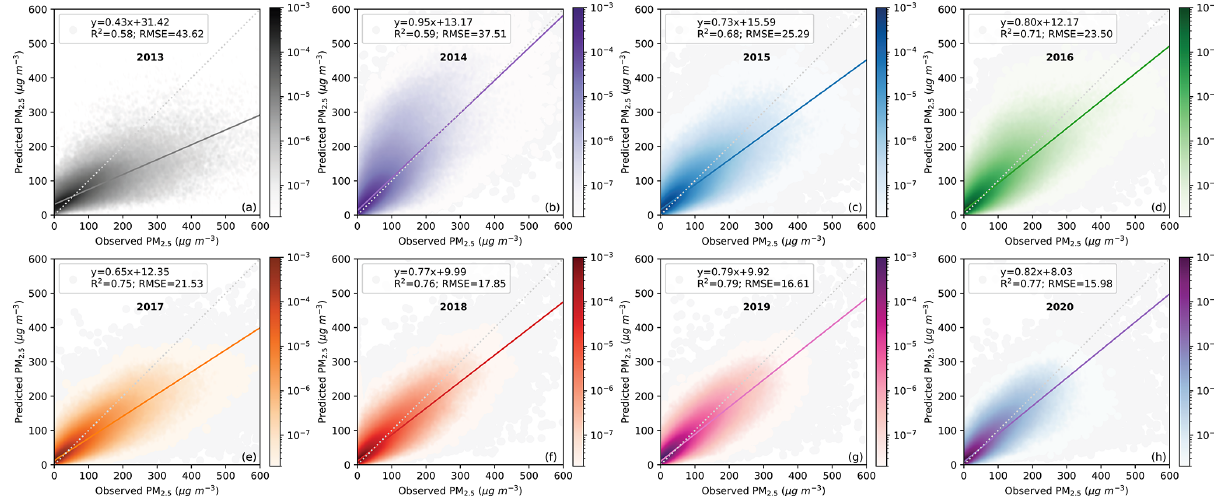
Figure 2. Density scatterplots of observed PM 2 . 5 and estimated PM 2 . 5 across China for by-year CV from 2013 to 2020. The time resolution for CV results is hourly and 6-hourly between 2013-2017 and hourly between 2017–2020. Colors are probability distribution